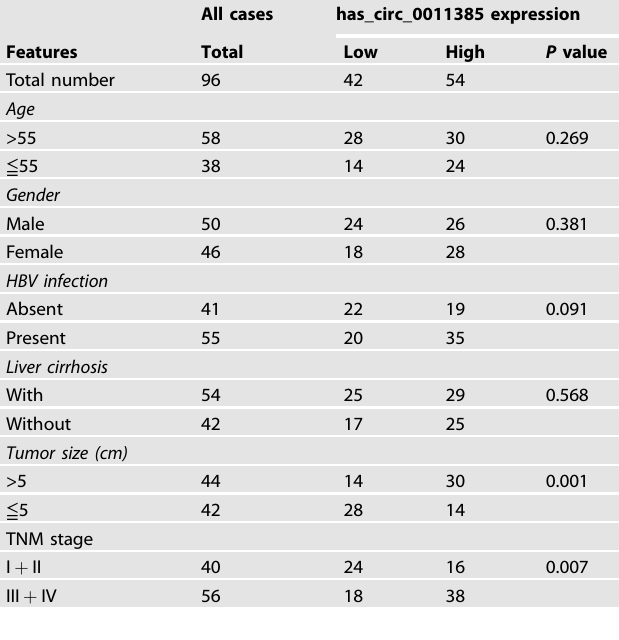
Table 1. The correlation between hsa_circ_0011385 expression and clinicopathological features in 96 HCC patients.